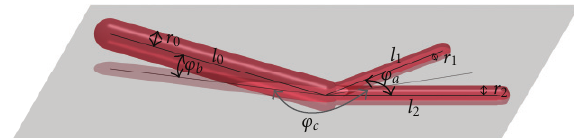
Figure 1: A bifurcation with the radii, lengths, and angles considered for our geometric